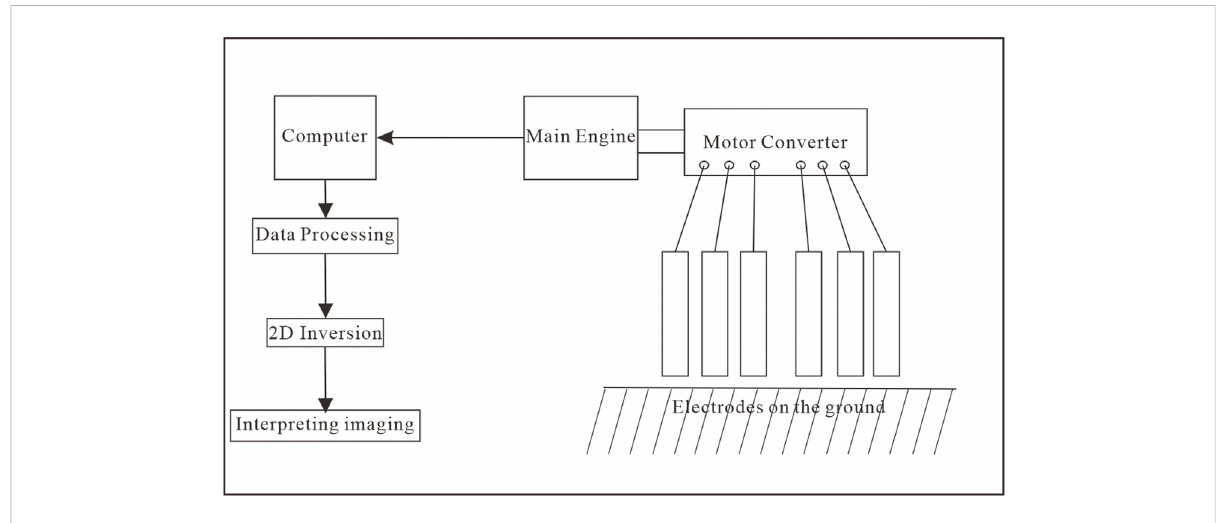
FIGURE 4 Working block diagram of the high-density resistivity method.